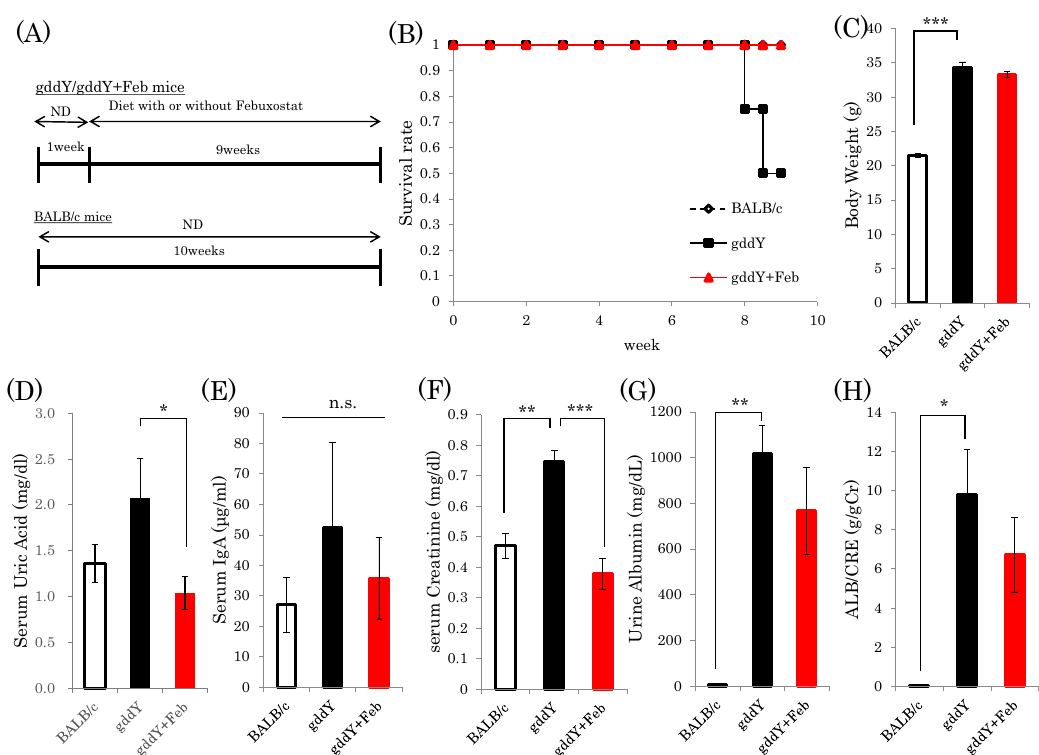
Figure 1. Xanthine oxidase inhibitor febuxostat prevents progression of IgA nephropathy. ( A ) Mice were divided into three groups: gddY mice with or without febuxostat treatment and BALB/c control mice ( n = 8). After 9 weeks, the mice were sacrificed and kidneys harvested. ( B ) Survival rates of mice at 9 weeks after the start of experiments are shown. ( C ) At 9 weeks, body weights were measured. ( D – F ) Serum UA, IgA, and creatinine contents were determined, respectively. ( G , H ) Urine albumin levels were measured and the ALB/CRE ratio was calculated. *: p < 0.05, **: p < 0.01, ***: p < 0.001. n.s.: not